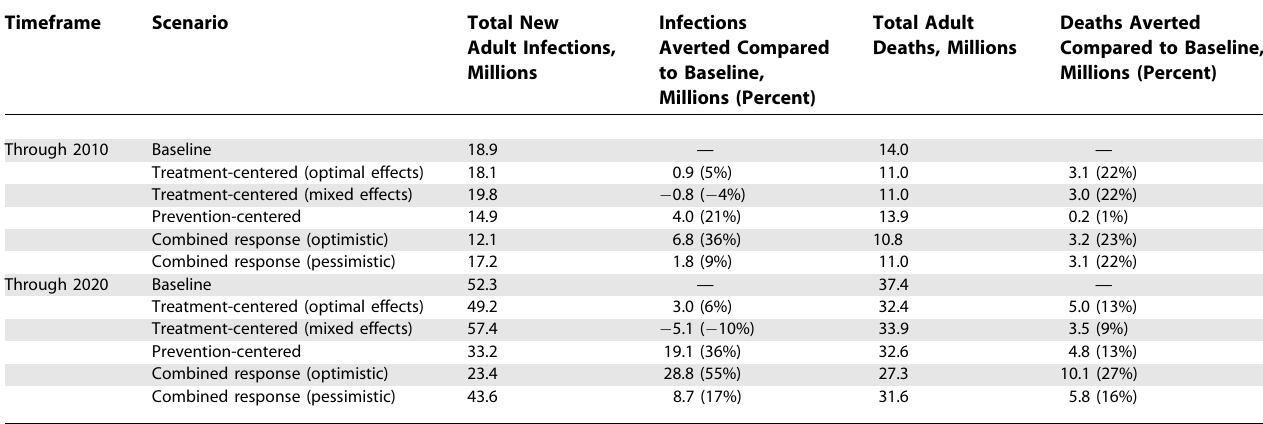
Table 1. Total New Adult Infections and Deaths in Sub-Saharan Africa, 2004–2010 and 2004–2020, under Different Intervention